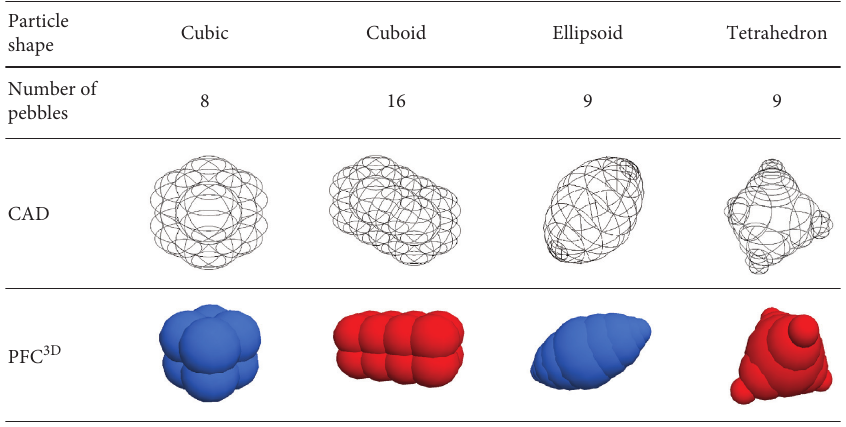
Figure 7: Idealized shape particles in these simulations.